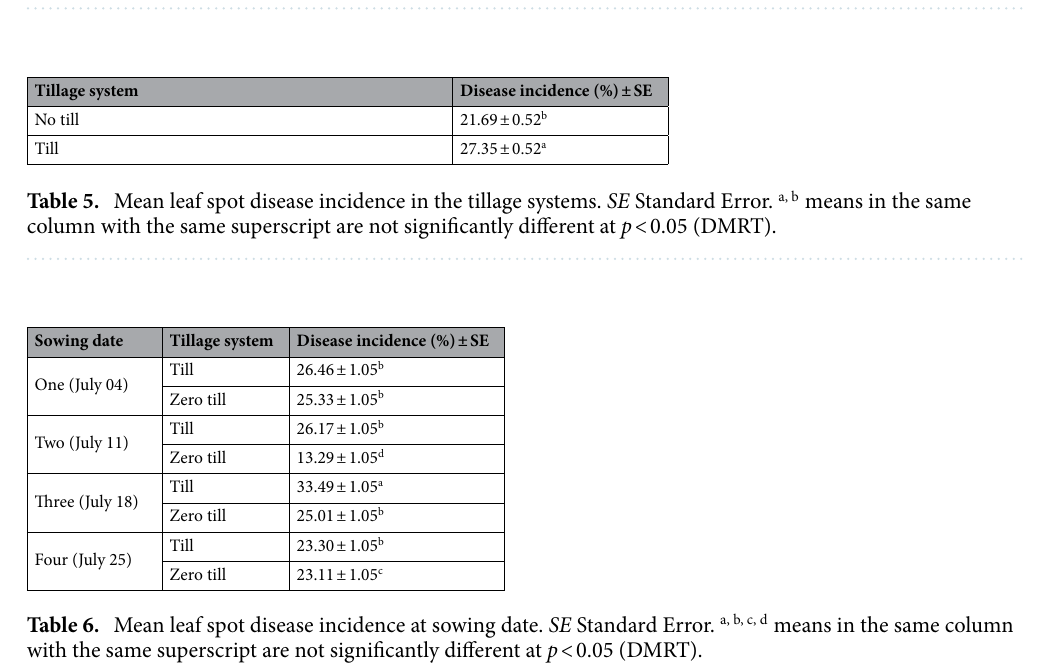
Table 4. Disease incidence in years of the study. SE Standard Error. a, b, c means in the same column with the same superscript are not significantly different at p < 0.05 (DMRT).